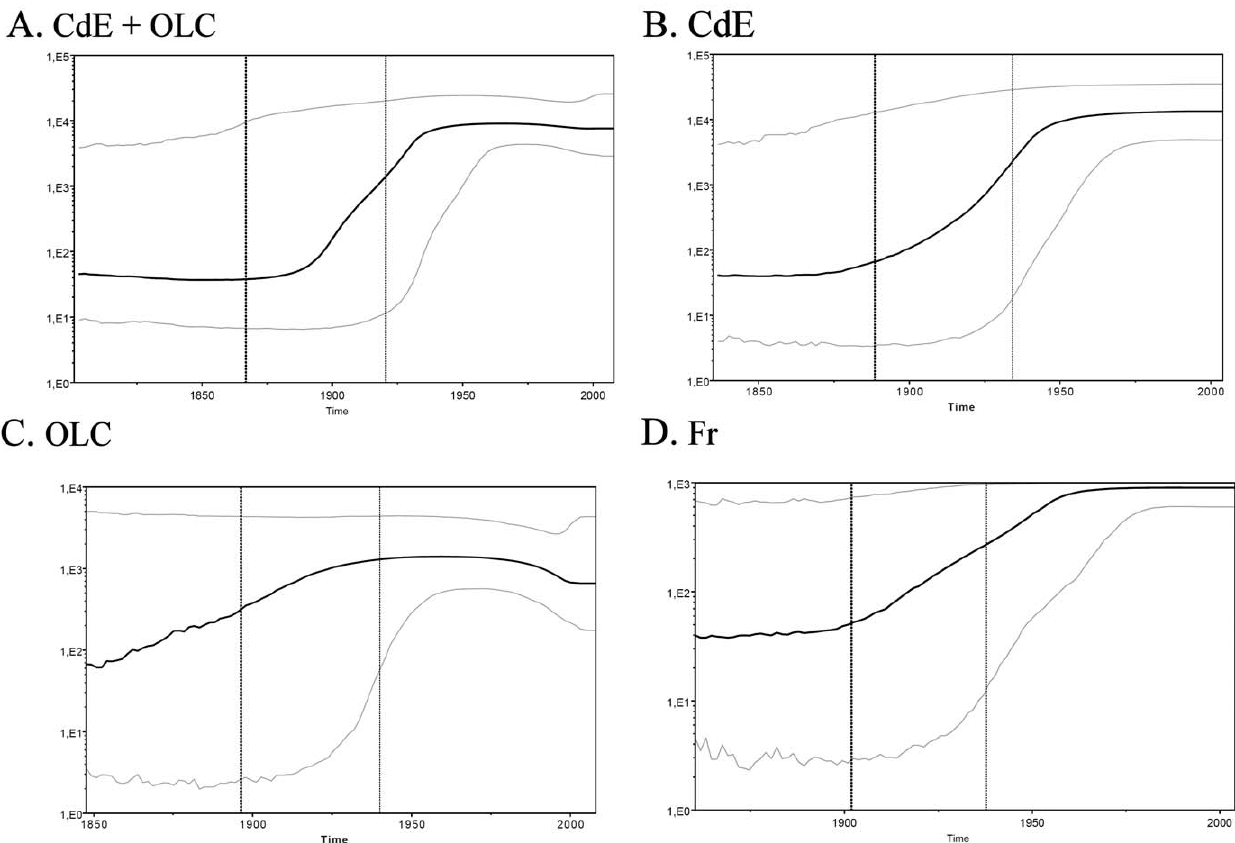
Figure 2. Bayesian Skyline Plots for Demographic Reconstruction using NS5B sequences. X axis : Date in Years A. C.; Y axis : Estimated effective number of infections; Bold Dashed Line : Median time of most recent common ancestor (t MRCA t MCRA ); Light Dashed Line : Upper HPD95% of t MRCA . Bold Line : Mean Effective Number of viral population. Blue Lines : Upper and Lower HPD95% of Effective Number of viral population. Analyzed data sets: A. CdE + OLC : Samples from Cruz del Eje and Other locations of Co´rdoba Province; B. CdE : Samples from Cruz del Eje; C. OLC : Samples from other locations of Co´rdoba Province; D. FR : Samples from South Western France (Cantaloube et al. , 2008).